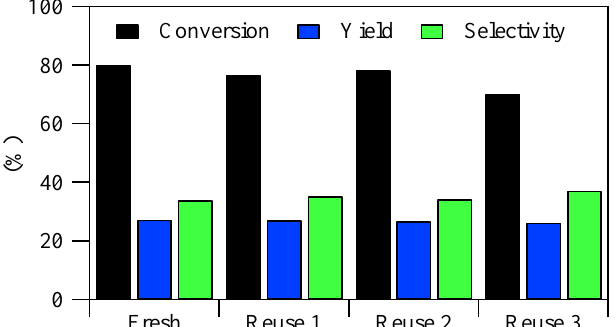
Figure 5. Recycling tests on the hydroxymethylation of furfural towards HMF over zeolite beta in a batch reactor. Reaction conditions: furfural (1–3 mmol), formalin (5–15 mL), catalyst (600–200 mg), temperature (363 K), time (6 h), stirring (500 rpm). The catalyst was re-calcined at 823 K before each reuse.